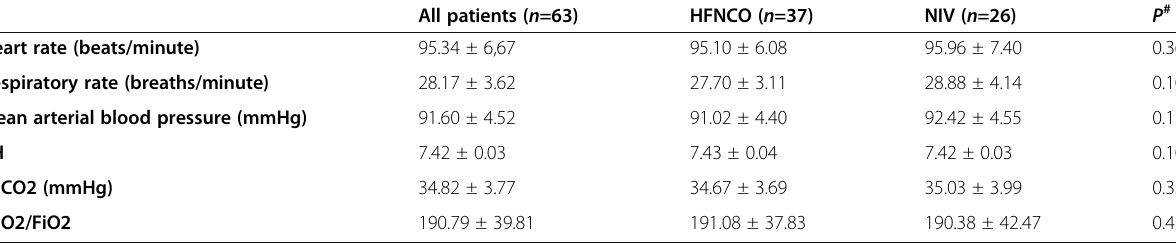
Table 3 Vital signs and blood gas analysis of the study population before treatment All patients ( n